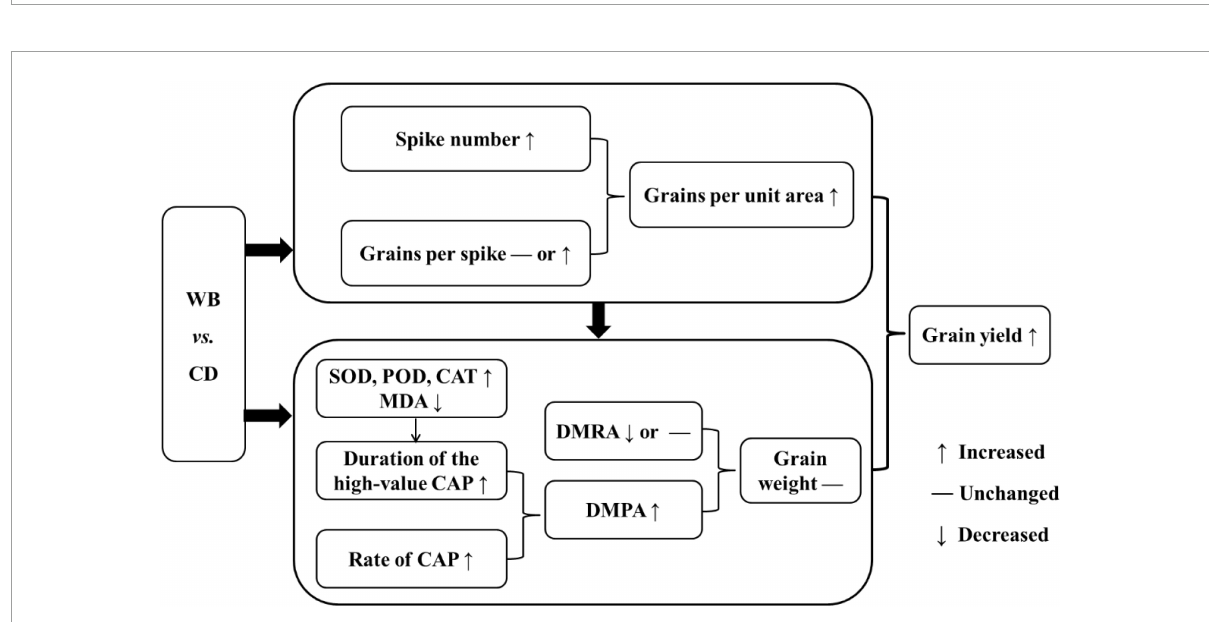
FIGURE11 The model of increased grain yield in wide belt sowing (WB) when compared with conventional drilling sowing (CD). SOD, superoxide dismutase; POD, peroxidase; CAT, catalase; MDA, malondialdehyde; CAP, canopy apparent photosynthesis; DMRA, dry matter remobilization amount in vegetative organs; DMPA, post-anthesis dry matter production